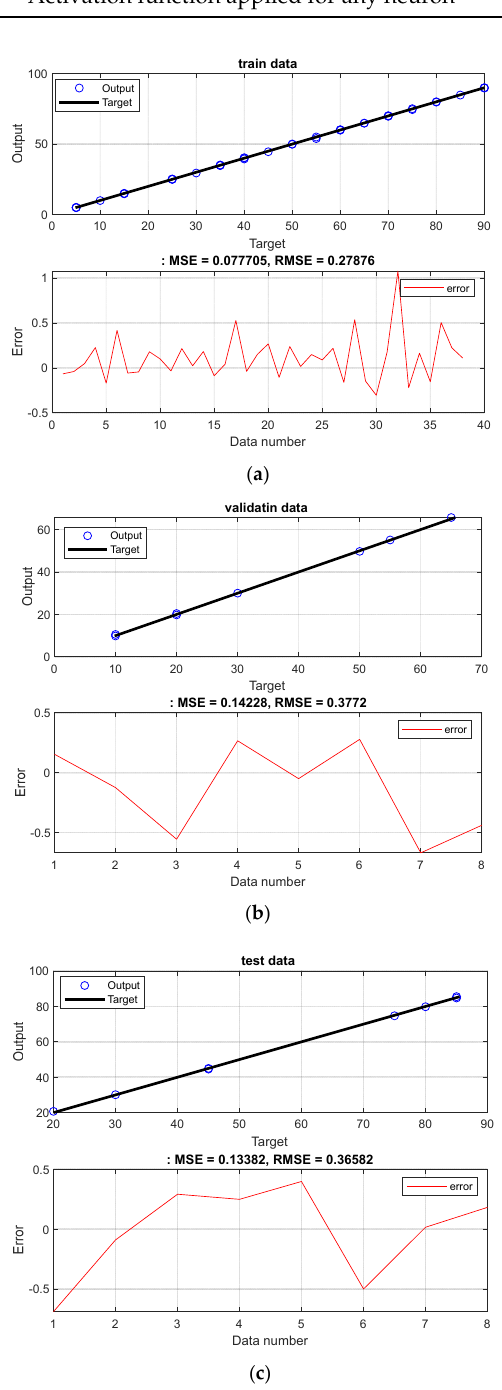
Figure 7. Results of the NN on three different types of data: ( a ) training, ( b ) validation, and ( c ) test ‐ ing. Table 3. Examination of the presented detection system’s accuracy in light of related research. Ref.